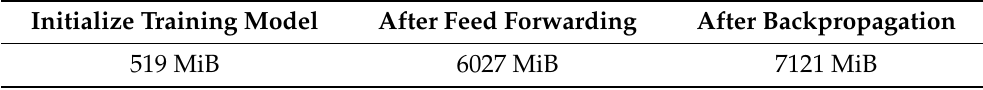
Table 2. GPU memory usage according to the training